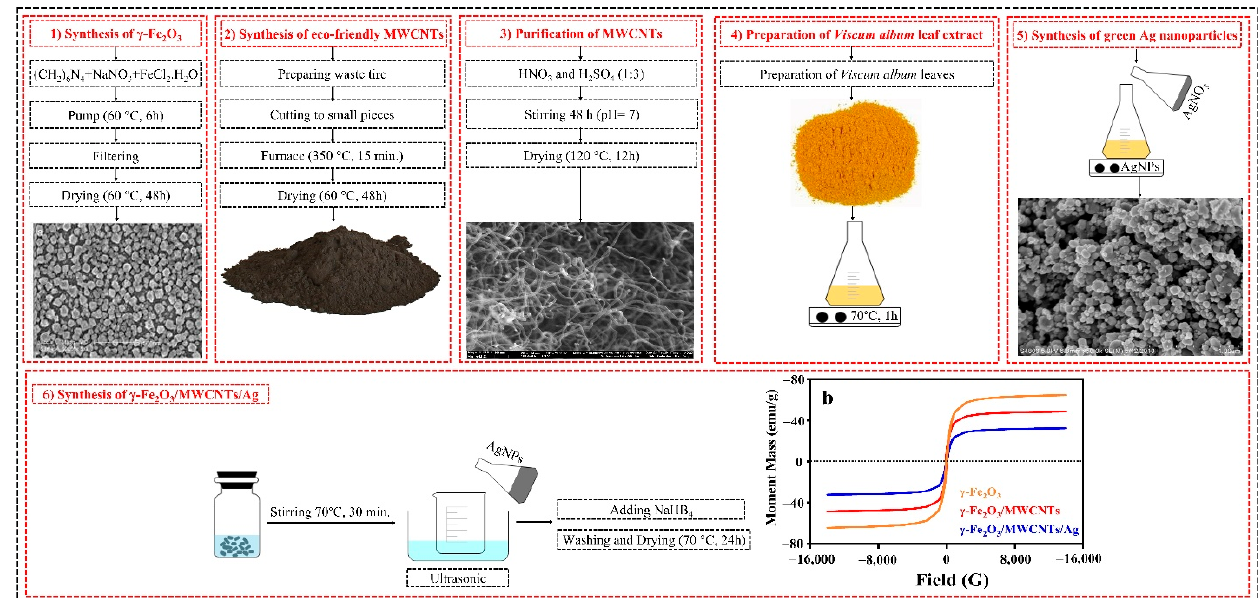
Figure 1. Schematic illustration of the synthesis process of the γ -Fe 2 O 3 /MWCNT/Ag NC